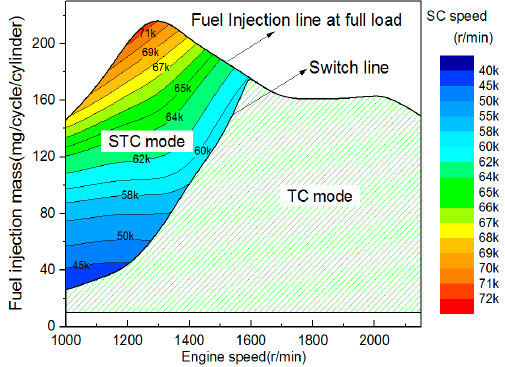
Figure 10. n sc of overall working conditions.